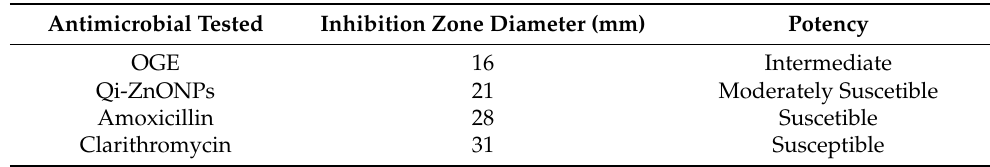
Table 2. The susceptibility test of the OGE, Qi-ZnONPs and antibiotics against H. pylori ATCC-43526 using the agar diffusion method. Antimicrobial Tested Inhibition Zone Diameter (mm) Potency OGE 16 Intermediate Qi-ZnONPs 21 Moderately Suscetible Amoxicillin 28 Suscetible Clarithromycin 31 Susceptible